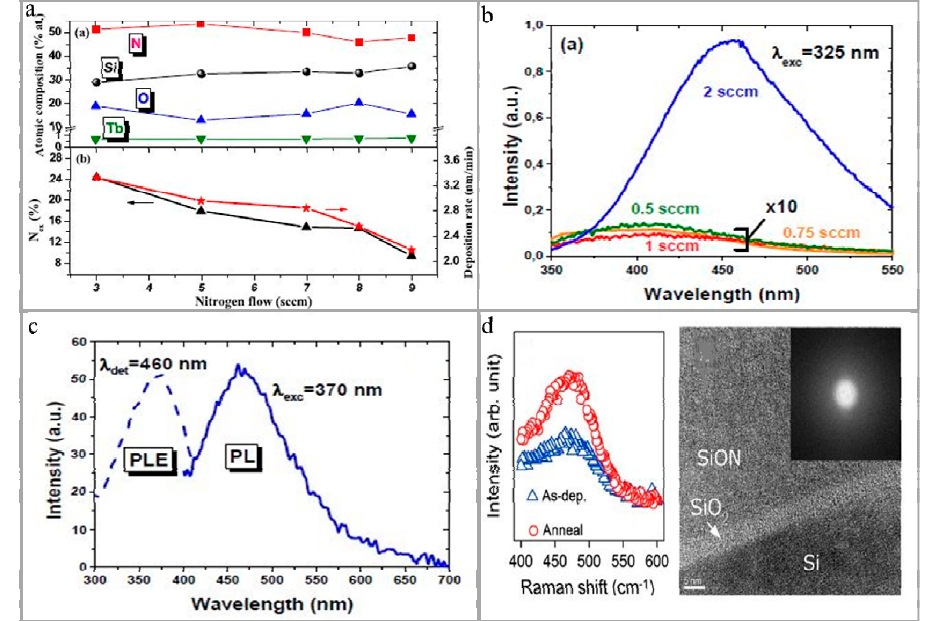
Figure 1. The luminescent performance of SiN x O y film. ( a ) Above part shows the effect of flow rate of N 2 on the atomic composition of the Tb-doped nitrogen-rich SiN x O y film, and below part shows the effect of the flow rate of N 2 on the nitrogen excess parameter (Nex) and deposition rate of the deposited layer [53]. Copyright 2017, Nanotechnology . ( b ) Effect of flow rate of N 2 on the PL of the Ce-doped SiN x O y film. ( c ) PL spectrum (solid line) and photoluminescence excitation spectrum (PLE) (dashed line) of a Ce-doped SiN x O y film at flow rate of N 2 of 2 sccm [55]. Copyright 2018, Nanoscale . ( d ) Effect of annealing temperature on SiN x O y film [46]. Copyright 2013, J. Lumin .